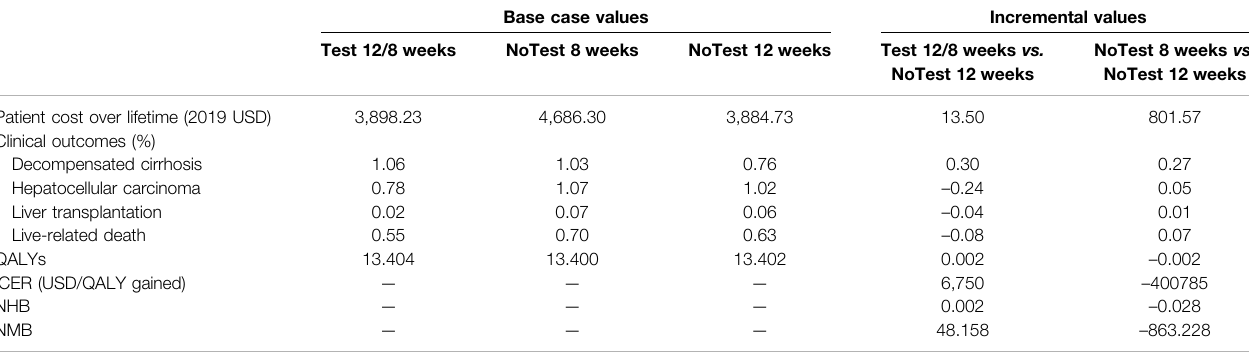
TABLE 2 | Summary of the cost and outcome results in base-case